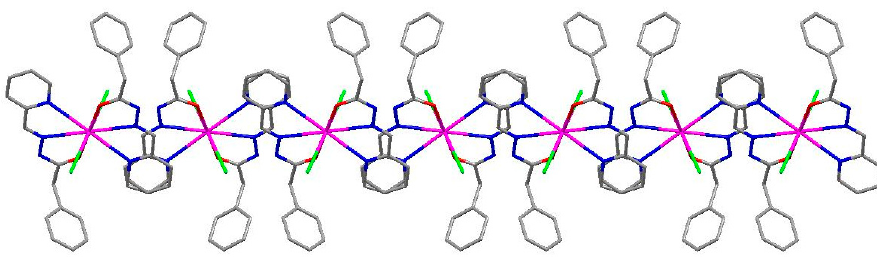
Figure 3. 1D chained structure by π - π stacking.